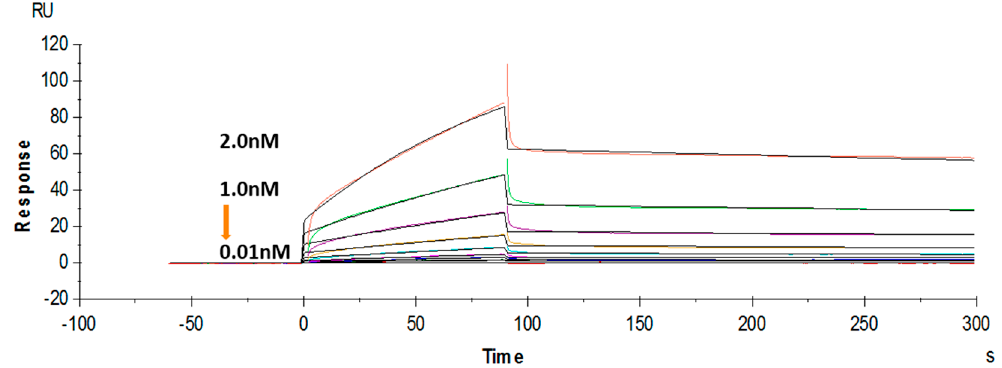
Figure 4. Binding kinetics of the anti-triazophos scFv-8C10 antibody measured via SPR.